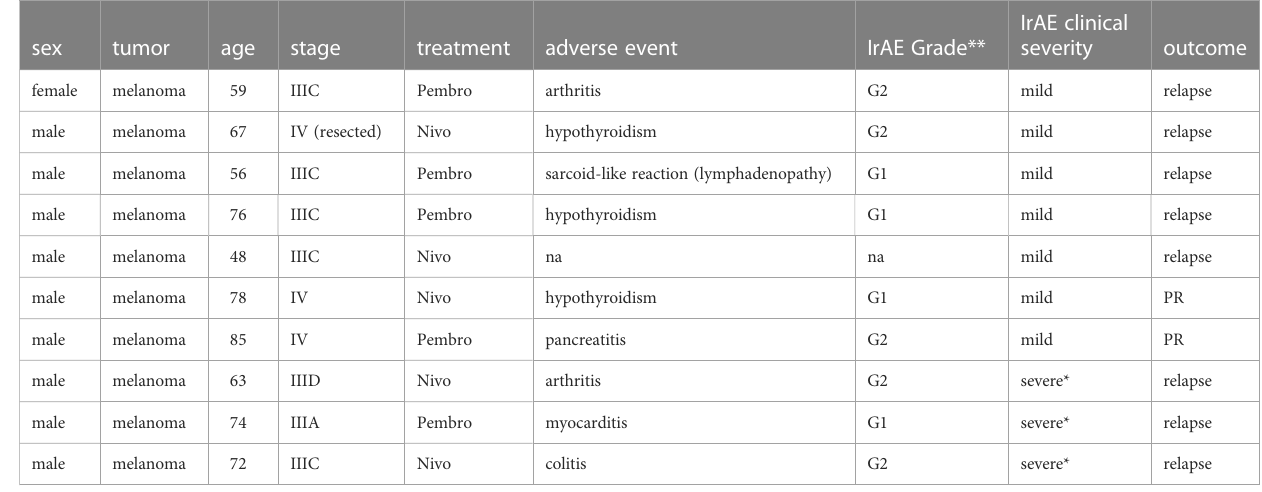
TABLE 1 Patients receiving PD-1 blocking monotherapy.